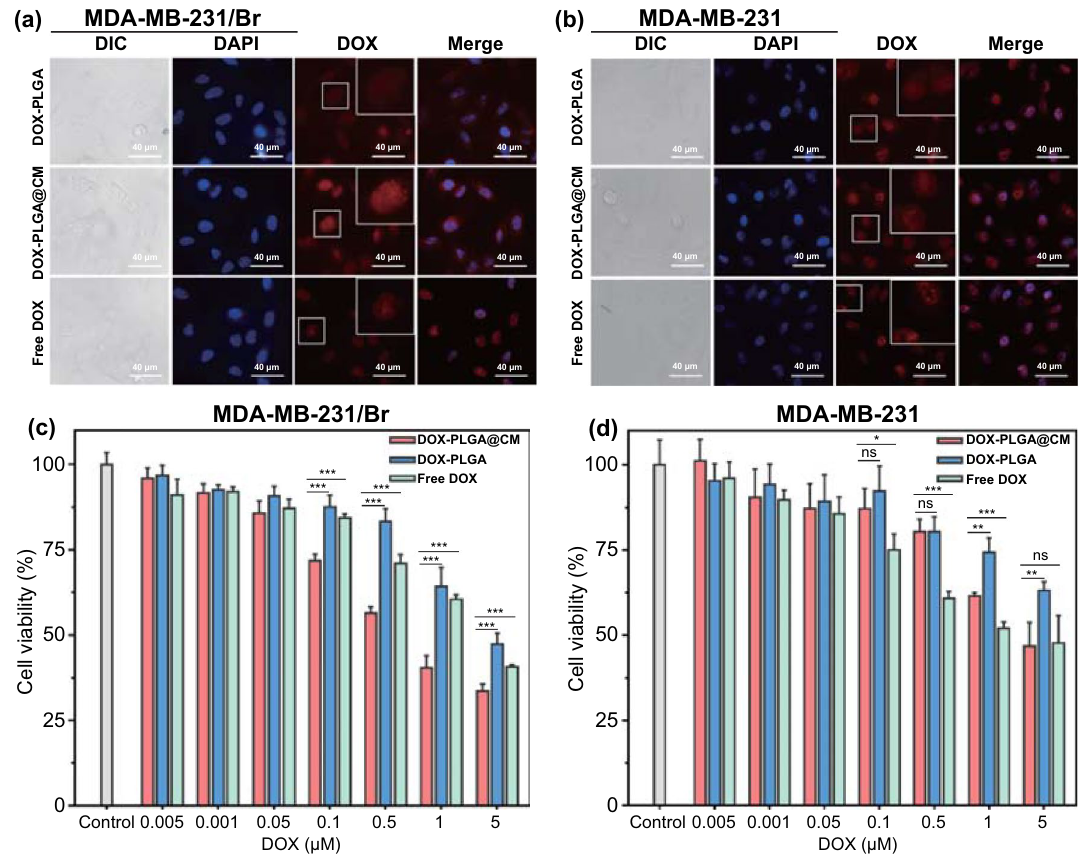
Fig. 2 Cellular uptake and cytotoxicity of DOX‑PLGA@CM nanoparticle. The cellular uptake of DOX‑PLGA, DOX‑PLGA@CM and Free DOX in MDA‑MB‑231/Br cells a and MDA‑MB‑231 cells b after 3 h of incubation. Cytotoxicity of DOX‑PLGA, DOX‑PLGA@CM, and Free DOX for MDA‑MB‑231/Br cells c and MDA‑MB‑231 cells d measured by MTT assay. Data were expressed as mean ± s.d. ( n = 3). * p < 0.05, ** p < 0.01, *** p < 0.001. n.s., not